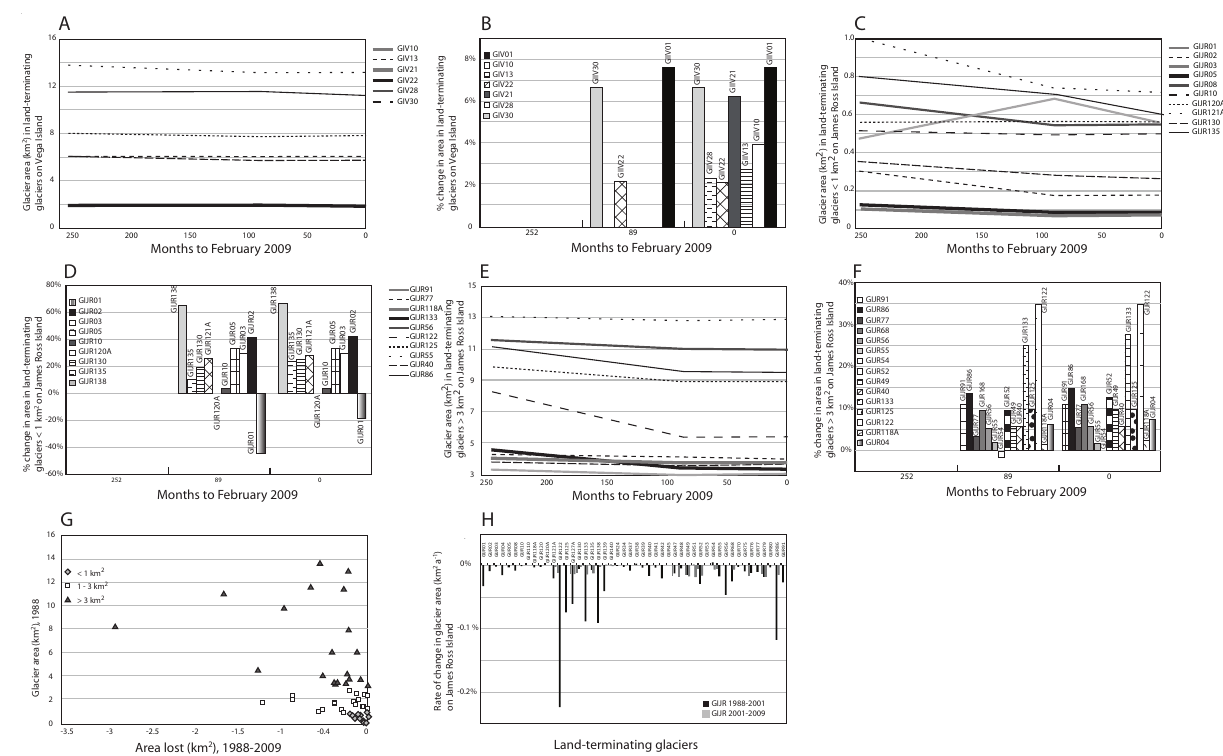
Fig. 5. Change in land-terminating glaciers on Vega Island and James Ross Island. (A) Percentage change in surface area on Vega Island. (B) Glacier shrinkage on Vega Island. (C) Percentage change for glaciers (less than 1 km 2 ) on James Ross Island. (D) Glacier change for small glaciers on James Ross Island. (E) Percentage change for glaciers > 3km 2 on James Ross Island. (F) Glacier change for glaciers greater than 3km 2 on James Ross Island. (G) Change in glacier area and initial glacier size ( r 2 = 0 . 11; see Table 5). (H) Variance in rates of change on James Ross